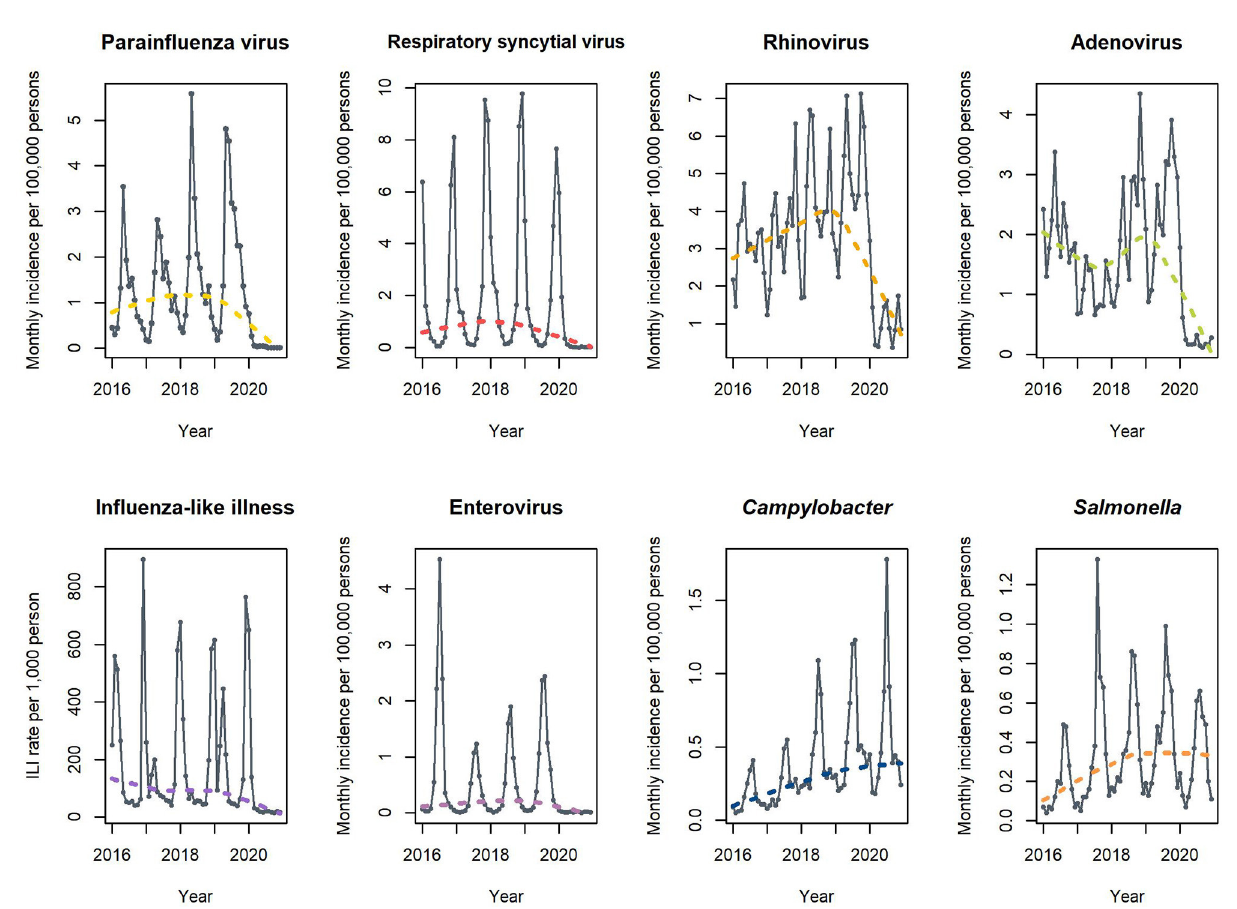
FIGURE3 Time-series analysis of the nationwide infections from a nationwide infectious surveillance system. Dotted lines present the trends of infectious diseases using locally weighted scatterplot smoothing. ILI, Influenza-like